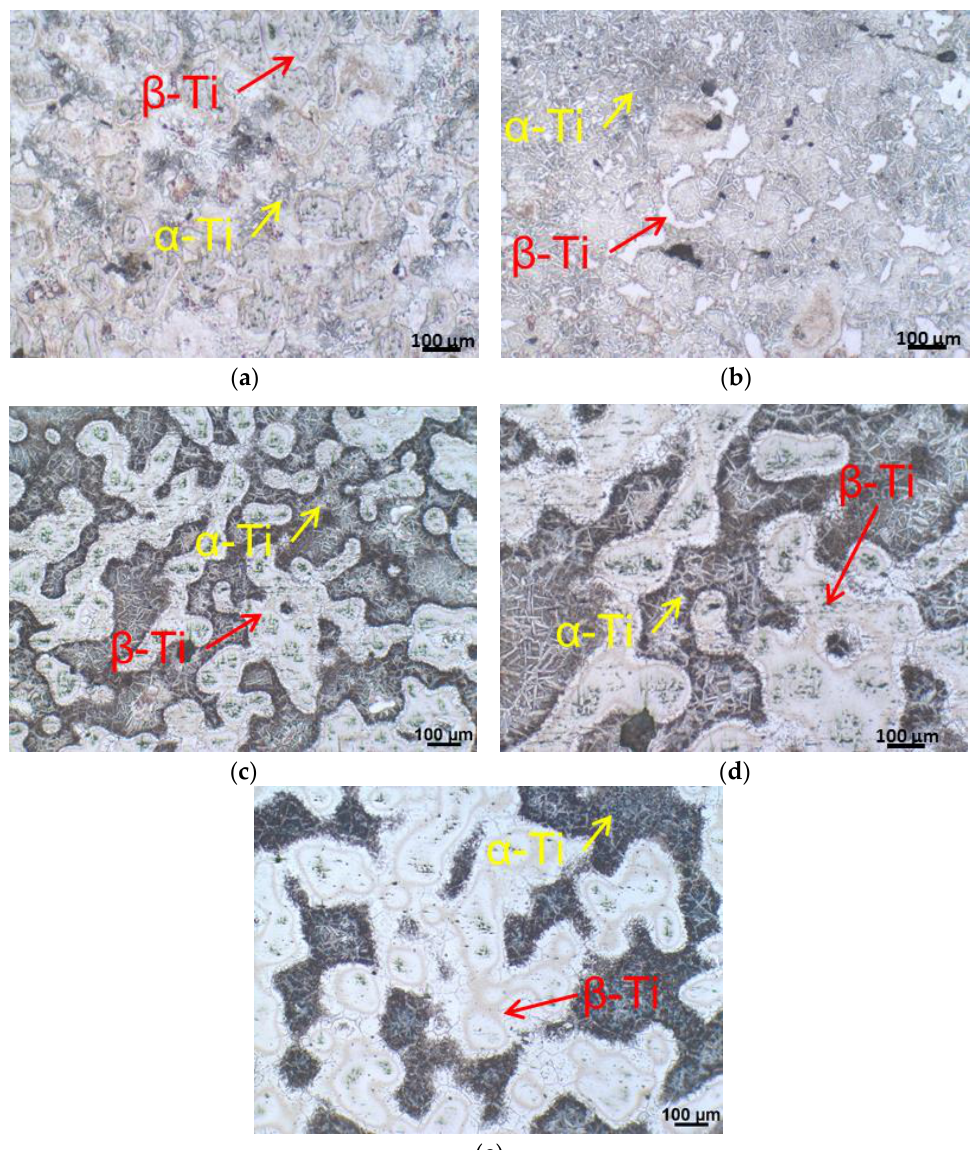
Figure 6. Optical micrographs of Ti-25Nb-6Zr specimens sintered at different temperatures: ( a ) 1223 K, ( b ) 1323 K, ( c ) 1423 K, ( d ) 1523 K, and ( e ) 1623 K.